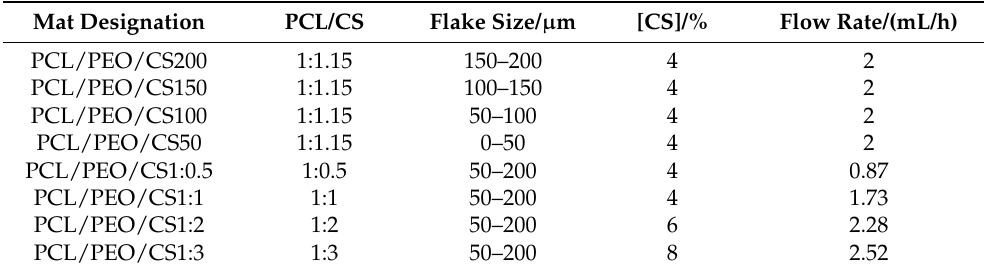
Table 1. Mat designation, PCL-to-CS mass ratio in the electrospun mats, CS flake size, CS concentra- tion in the PEO solutions, and flow rate of PEO/CS solution during